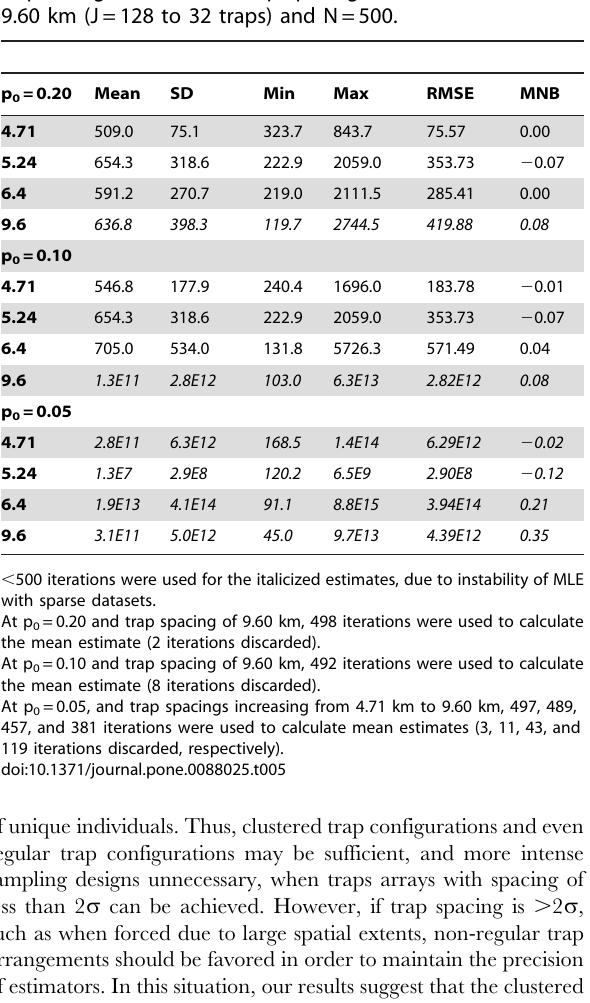
Table 7. RMSE values of estimators of ^ NN , as effective trap spacing (i.e., trap spacing/ s ) increased under the regular trap configuration and across all baseline detection